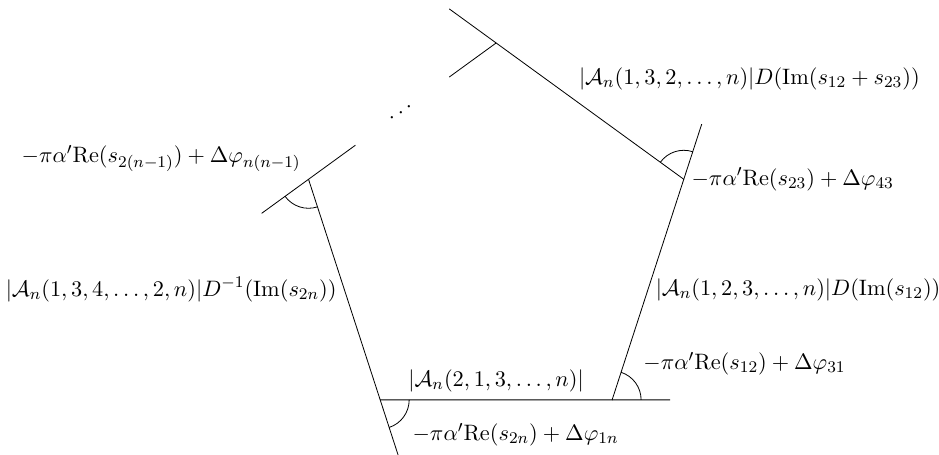
Figure 13. Plahte diagram for N -point open tachyon string amplitudes with complex momenta corresponding to the Plahte identity